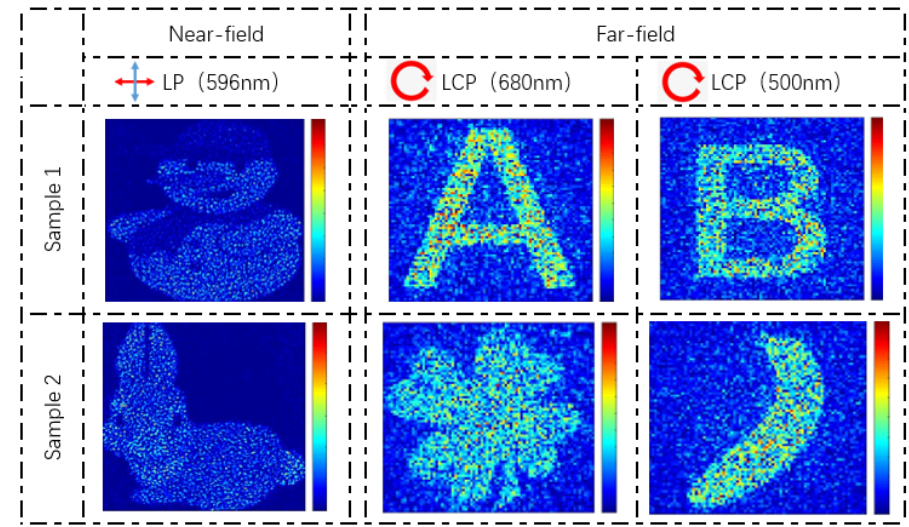
Figure 7. Simulation results of the metasurfaces for three ‐ channel holography and nanoprinting. The first row and the second row respectively show the simulation results in sample 1 and sample 2. The first column shows the nanoprinting images under LP light (596 nm) in the near ‐ field. The second column and the third column show the holographic images under CP light (680 nm, 500 nm) in the far ‐ field. The red arrow represents the polarization direction α 1 of the incidence light and the blue arrow represents the analyzer polarization α 2.